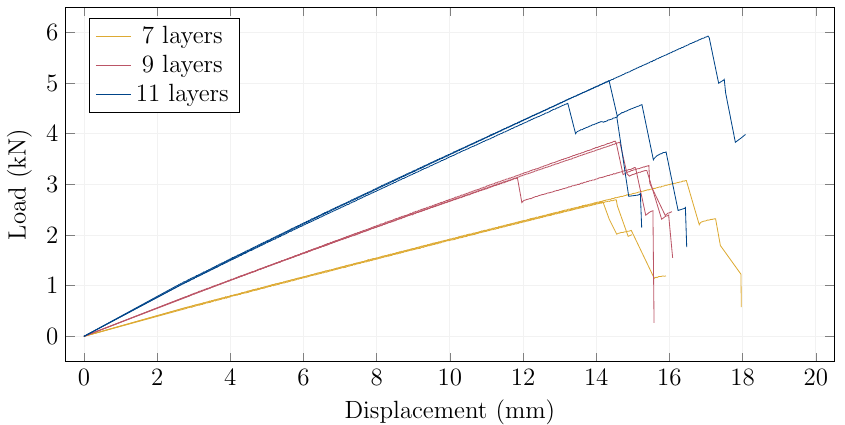
Figure 4. Load–displacement diagrams of all tested undamaged 7-, 9-, and 11-layer specimens (bottom, middle, top line groups,